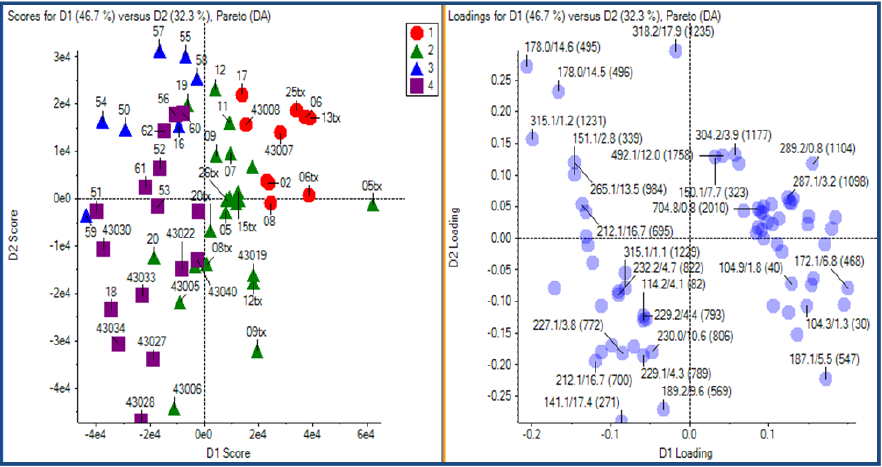
Figure 7. PCA-DA plots of the clear cell renal cell carcinoma (ccRCC) HILIC-LC–ESI–MS after manual feature